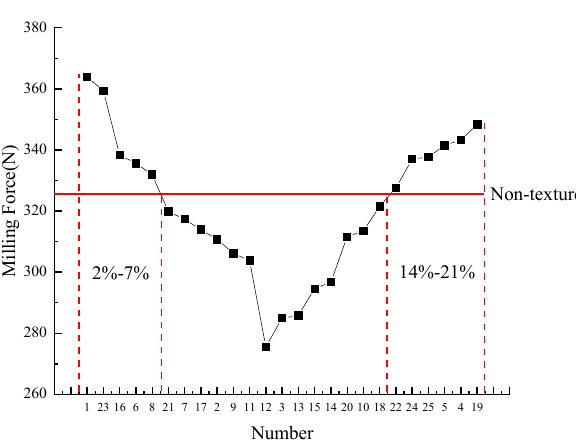
Figure 16. Proportion of micro-textured area in contact area of ball-end milling tool with blunt tool edge.